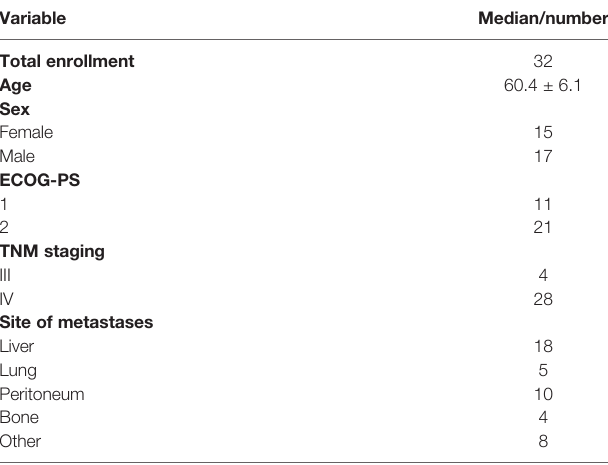
TABLE 2 | Demographics and baseline characteristics of patients with